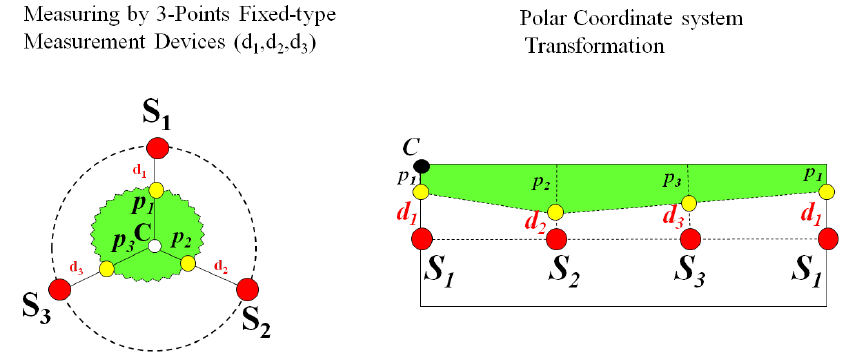
Figure 19. Generation of thickening form of the target plant (fixed-type).